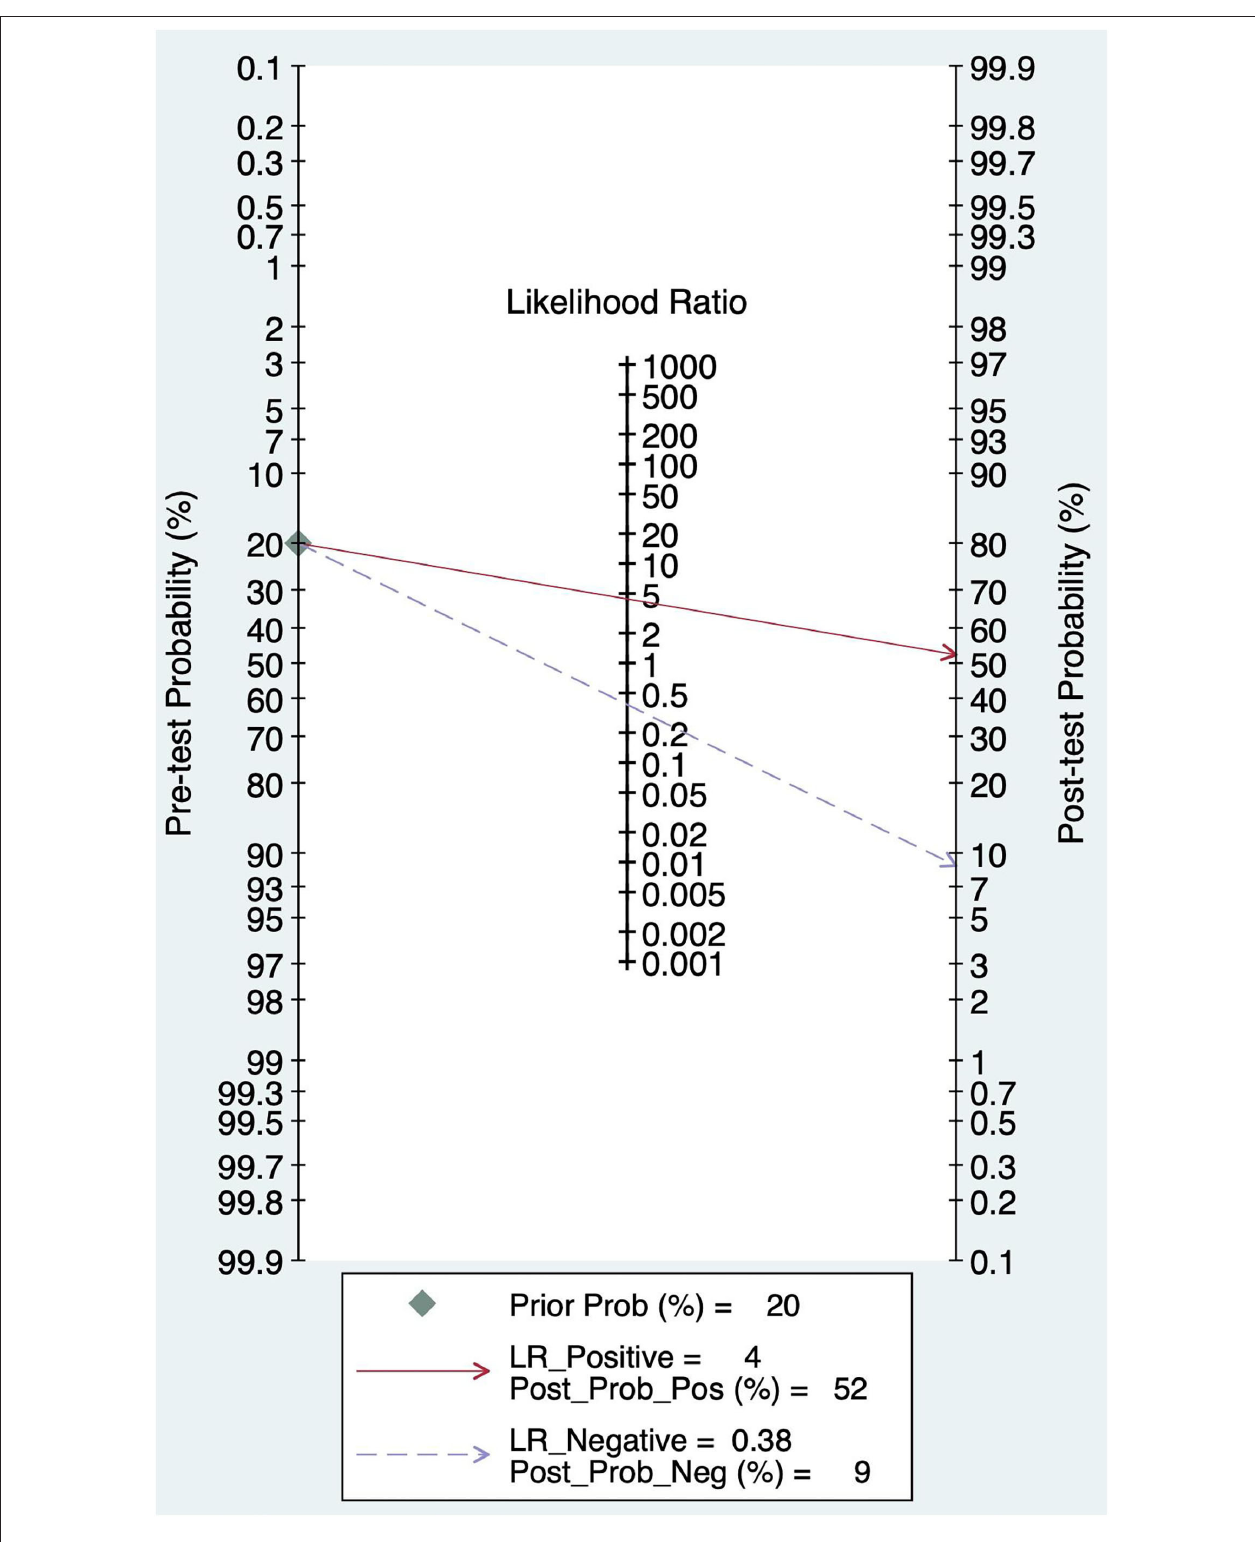
FIGURE 10 | Fagan diagram of BEFAST in the diagnosis of AIS.